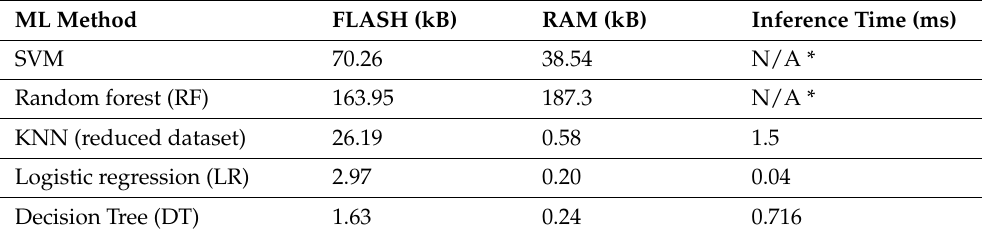
Table 5. Implementation results for memory footprint and inference time on 8-bit AVR